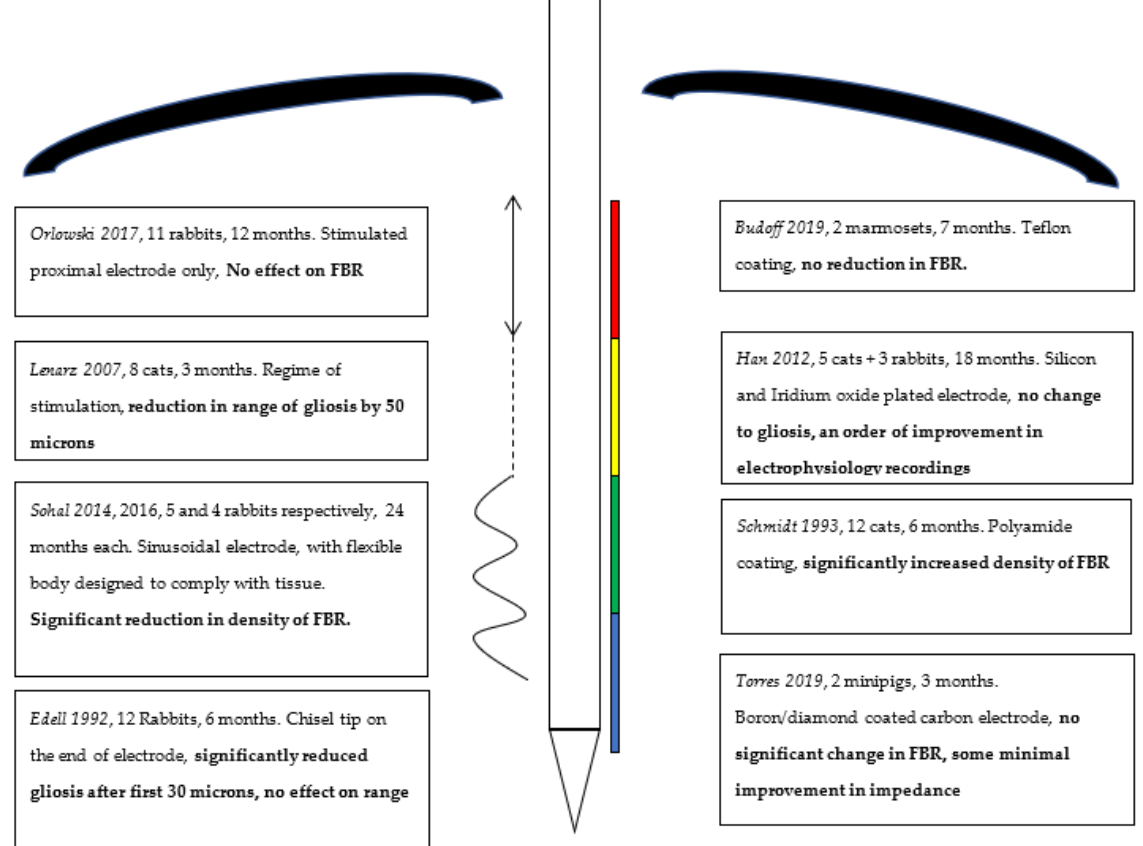
Figure 3. Schematic summary of interventions, coatings on right and electrode structure modifications on left, with conclusions highlighted in bold.